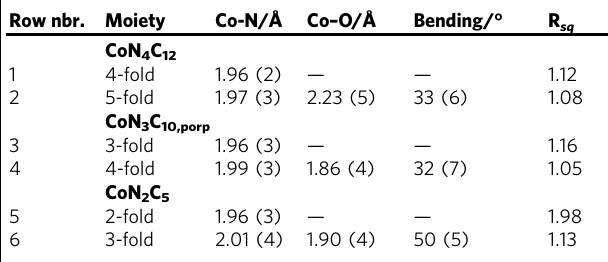
Abbreviation: XANES, X-ray absorption near-edge structure Best- fi t structural parameters obtained from the analysis of the XANES spectrum of Co 0.5 performed on the structures proposed in this work and depicted in Fig. 3. Bending is the angle between the Co – O vector and the O-O bond and R sq is the residual function. Errors are given in